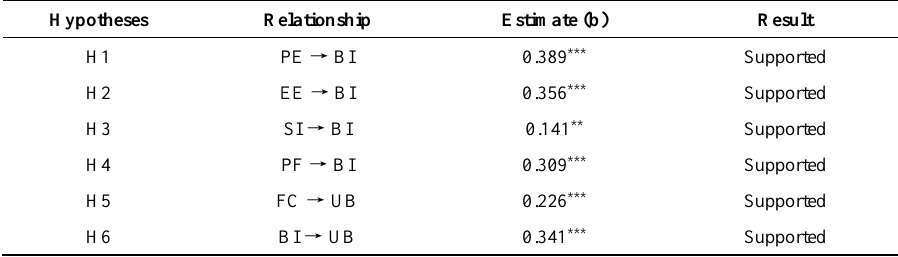
Table 5. Structural parameter